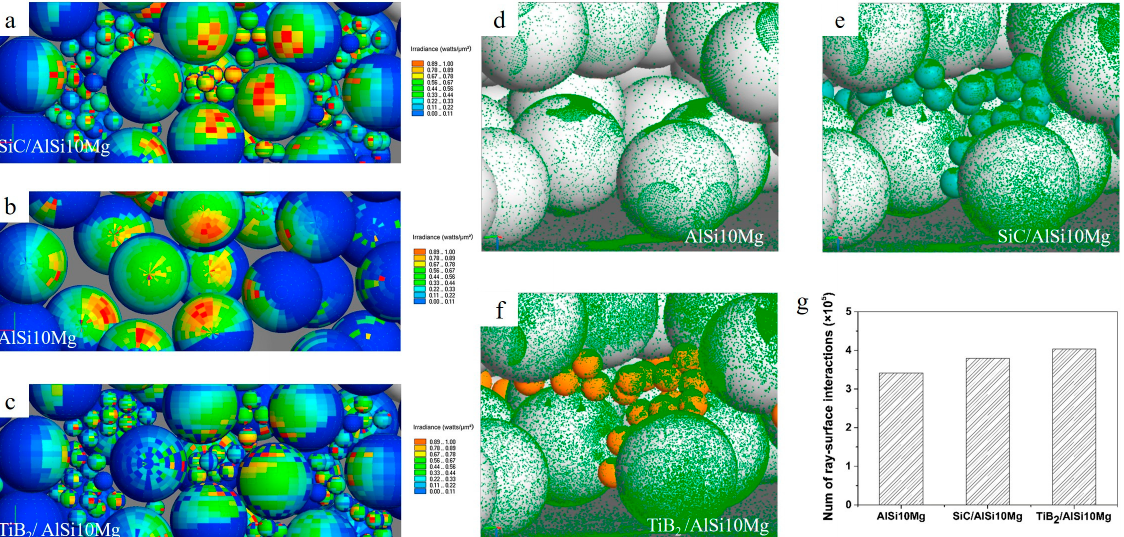
Figure 2. Irradiance distribution for SiC/AlSi10Mg ( a ), AlSi10Mg ( b ), TiB 2 /AlSi10Mg ( c ) powder mixtures (top view). Illustration of track spot of each laser ray on the particle surface of AlSi10Mg ( d ), SiC/AlSi10Mg ( e ), TiB 2 /AlSi10Mg ( f ) (side view) and numerical representation of laser–particle interactions ( g ) (reproduced with permission from [76]).